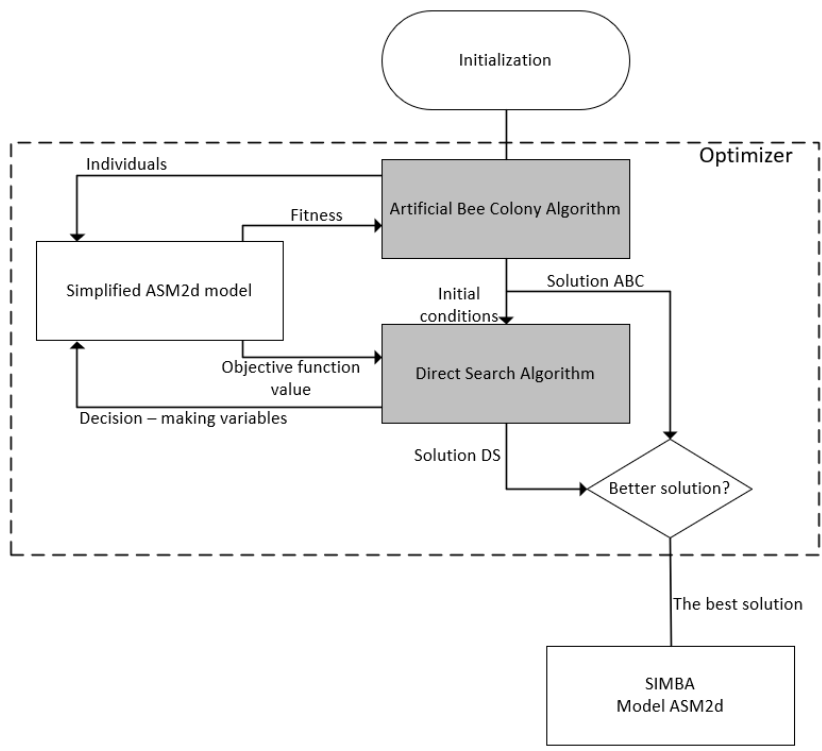
Figure 5. Scheme of the optimization process.